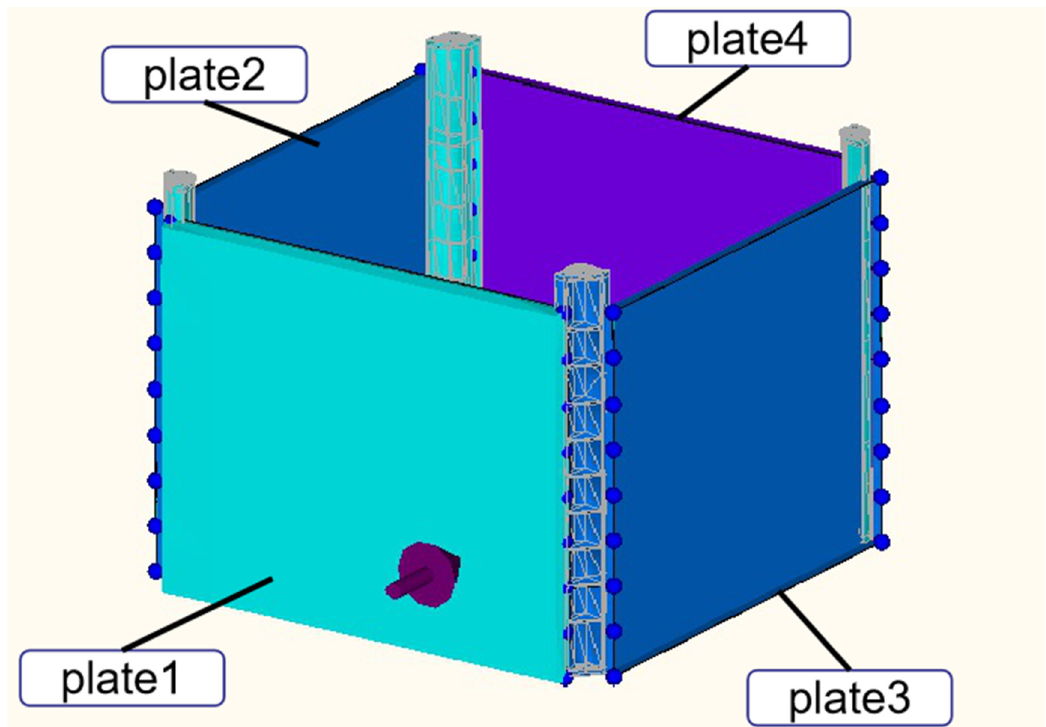
Figure 8. The hybrid FE-SEA model of spacecraft structure.